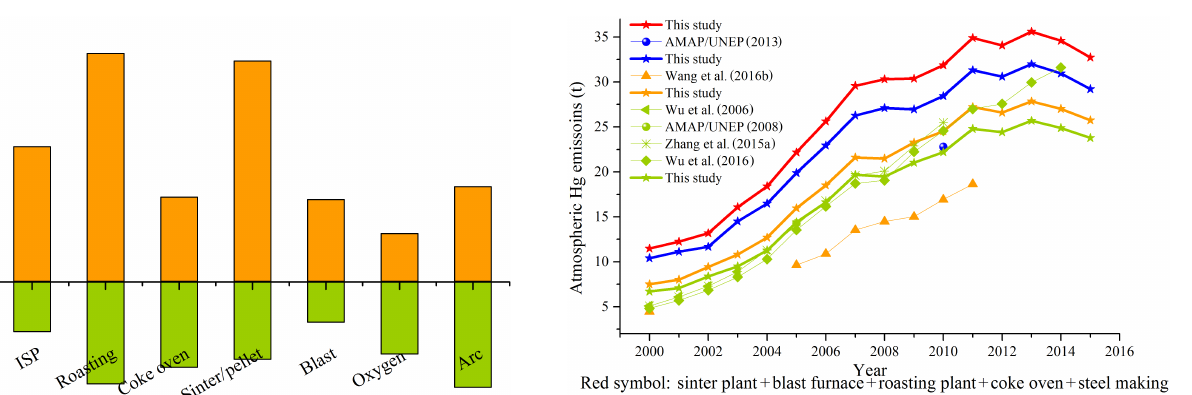
Figure 6. Atmospheric Hg emissions of ISP in different